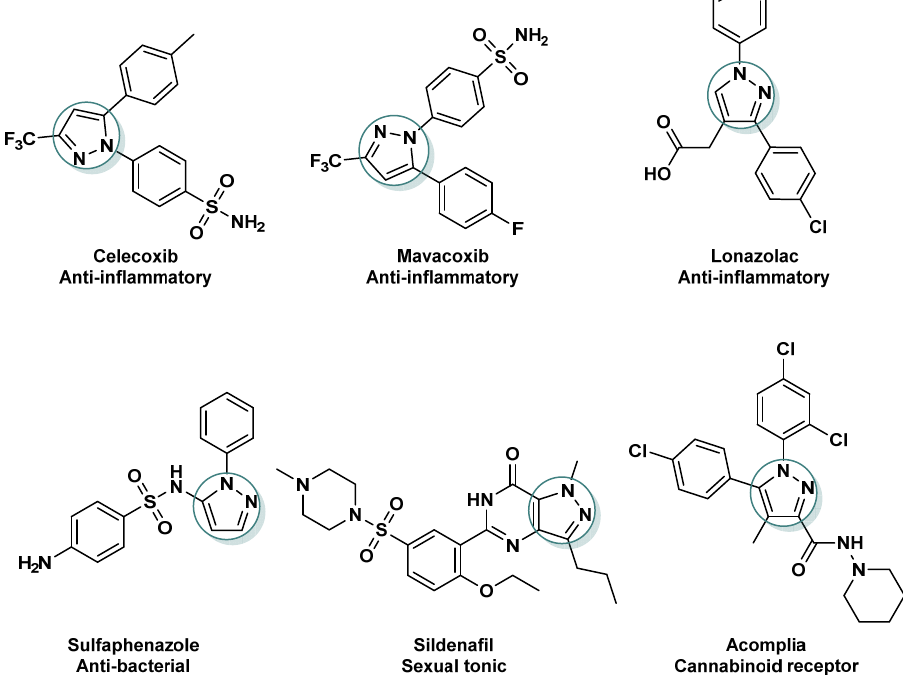
Figure 1. Several biologically active molecules containing pyrazole.